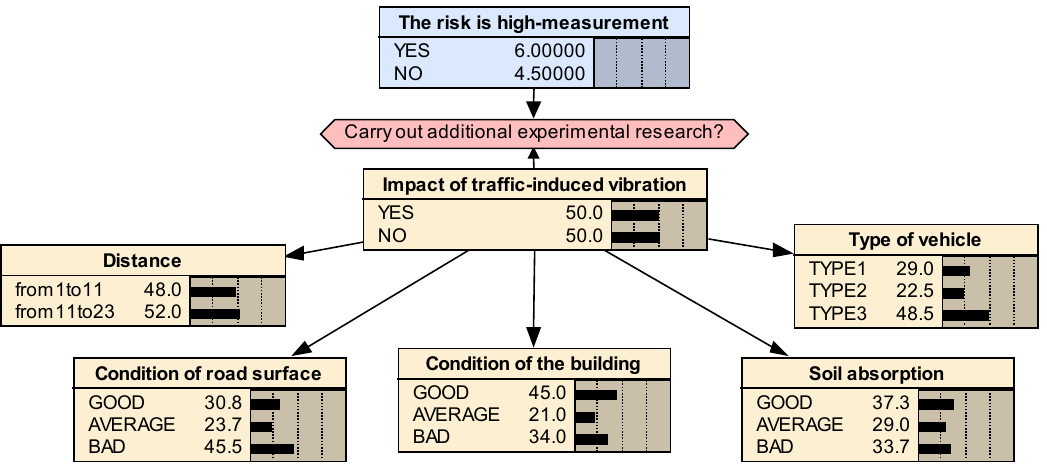
Figure 3. Model of a Bayesian network (BN) for impact of traffic-induced vibrations on residential buildings.